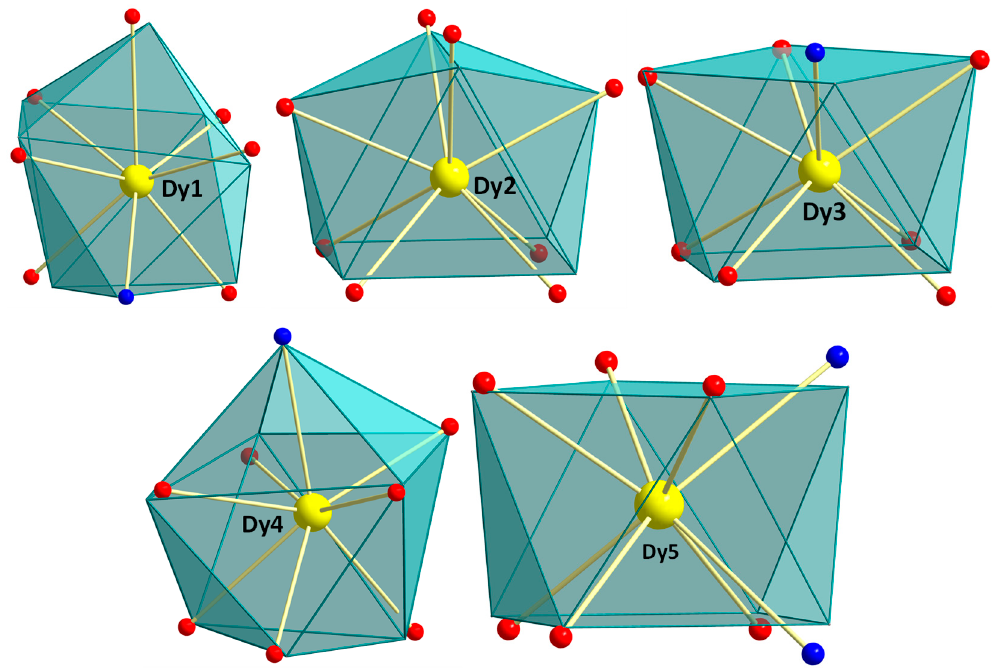
Figure 3. Square antiprismatic, triangular dodecahedral and biaugmented trigonal prismatic coordination geometries of the Dy atoms in 1 . Points connected by the gray thin lines define the vertices of the ideal polyhedra.